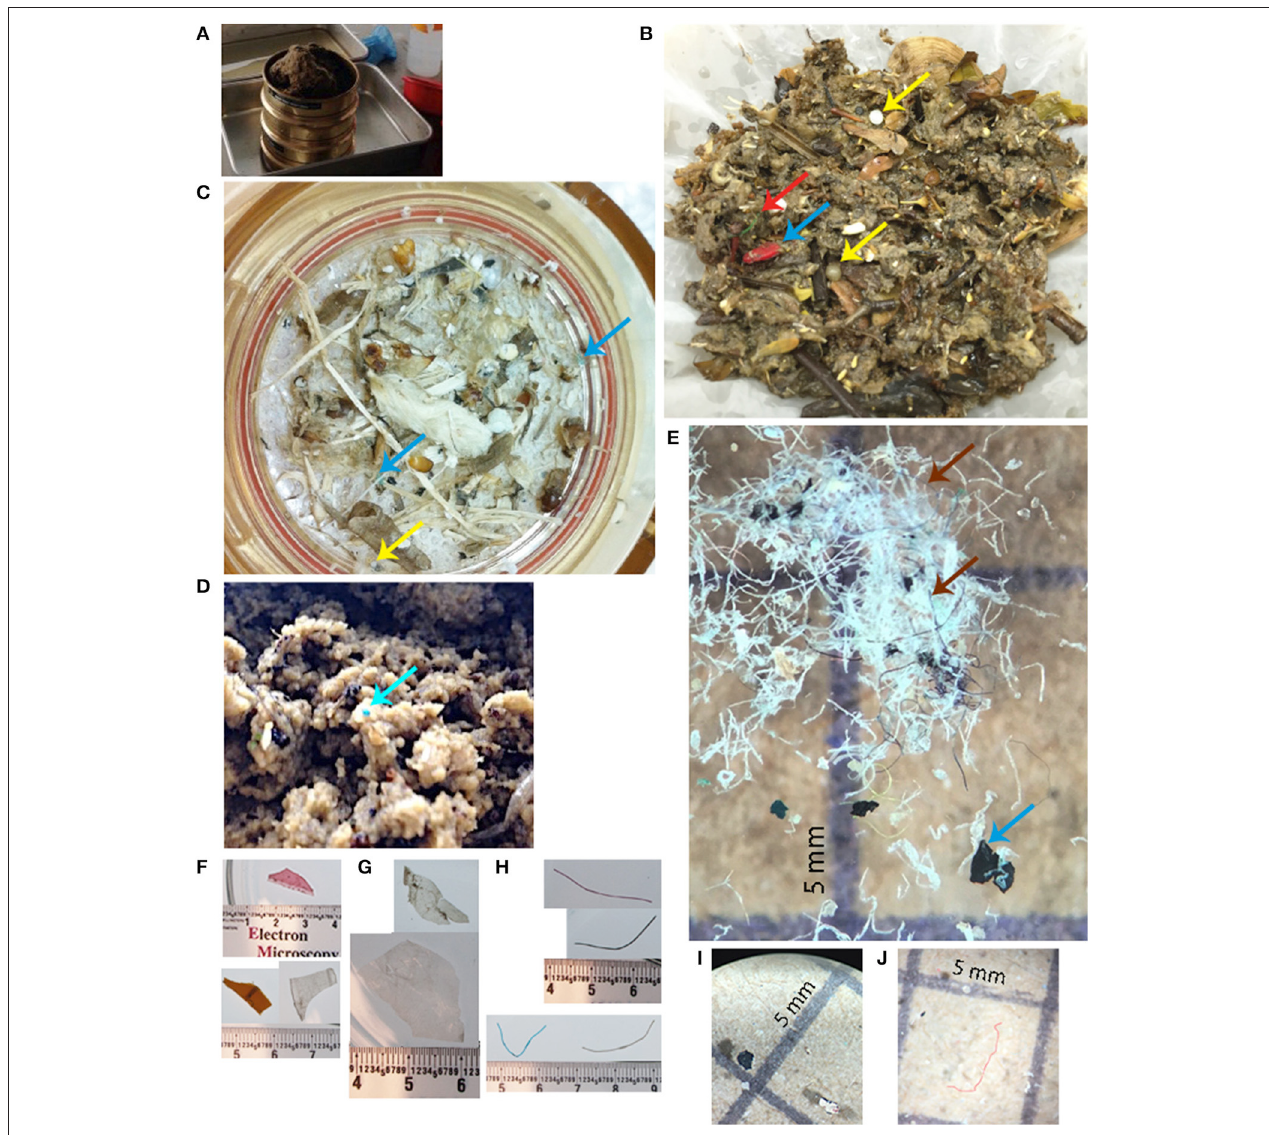
FIGURE 2 | Photographs of samples at various stages of processing, as well as examples of different shape classes. Arrows indicate plastic amidst co-sampled nonplastic organic matter; blue: fragment, dark red: line, yellow: nurdles, cyan: sphere/bead, brown: fiber. (A) Bulk sample directly upon retrieval from Manta on a stack of a series of sieves. This sample contained an abundance of algal biomass. (B) Bulk sample drying on a 53 µ m mesh net. (C) Sample after enzymatic processing, which included an incubation in hydrogen peroxide that bleached much of the non-plastic organic matter. This bleaching aided in differentiating plastic (tended to retain color) from non-plastic (prone to bleaching) particles. (D) Examples of plastic of sphere class; zoomed in subset of sample in (B) . (E) Smallest size fraction (106–1,000 µ m) after WPO. Note colored plastic fibers (brown arrows) enmeshed in mass of natural fibers bleached white from hydrogen peroxide treatment. (F–H) Examples of plastic of fragment, film and line shape classes, respectively; ruler markings are in cm units. (J,I) Examples of plastic of paint chip and fiber shape classes, respectively; grid squares are in 5 mm